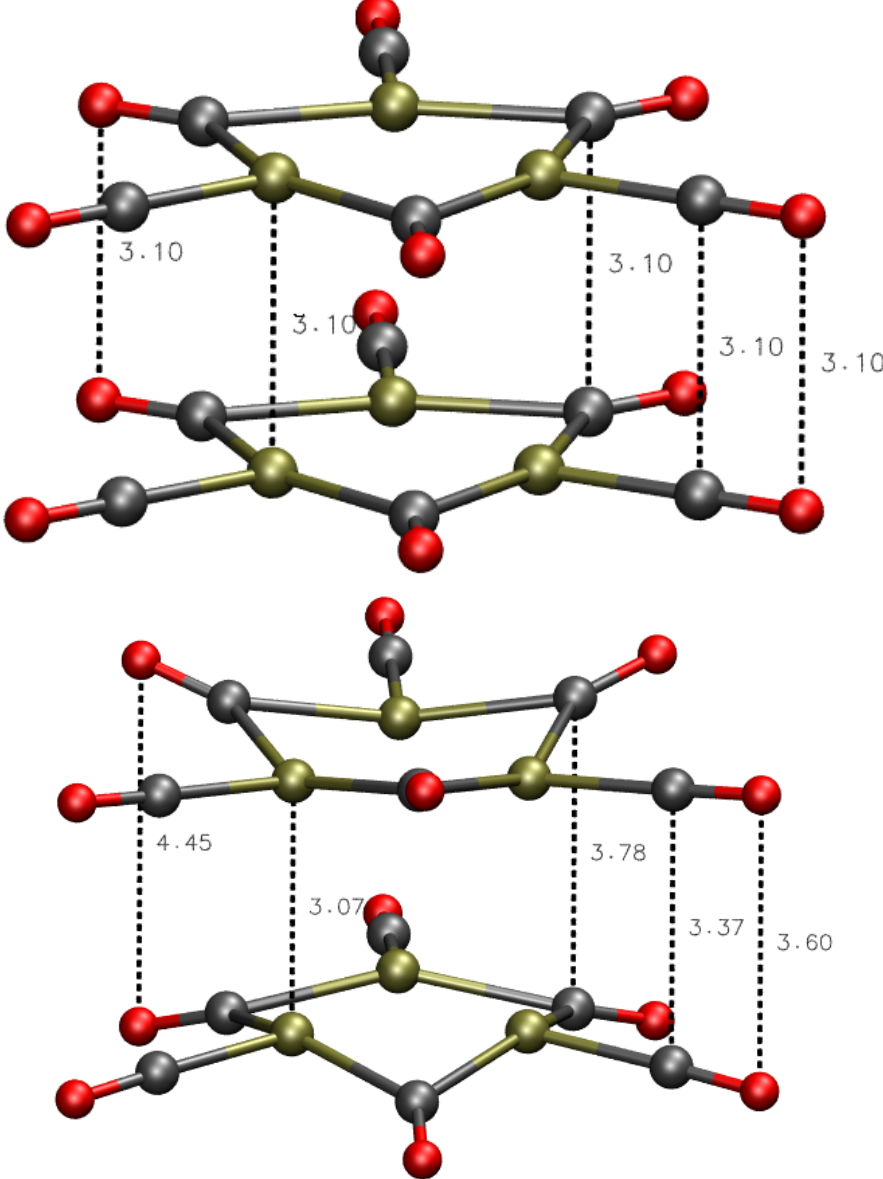
Figure 4. Geometry of dimer with charge q = − 2 before ( top ) and after energy ( bottom )